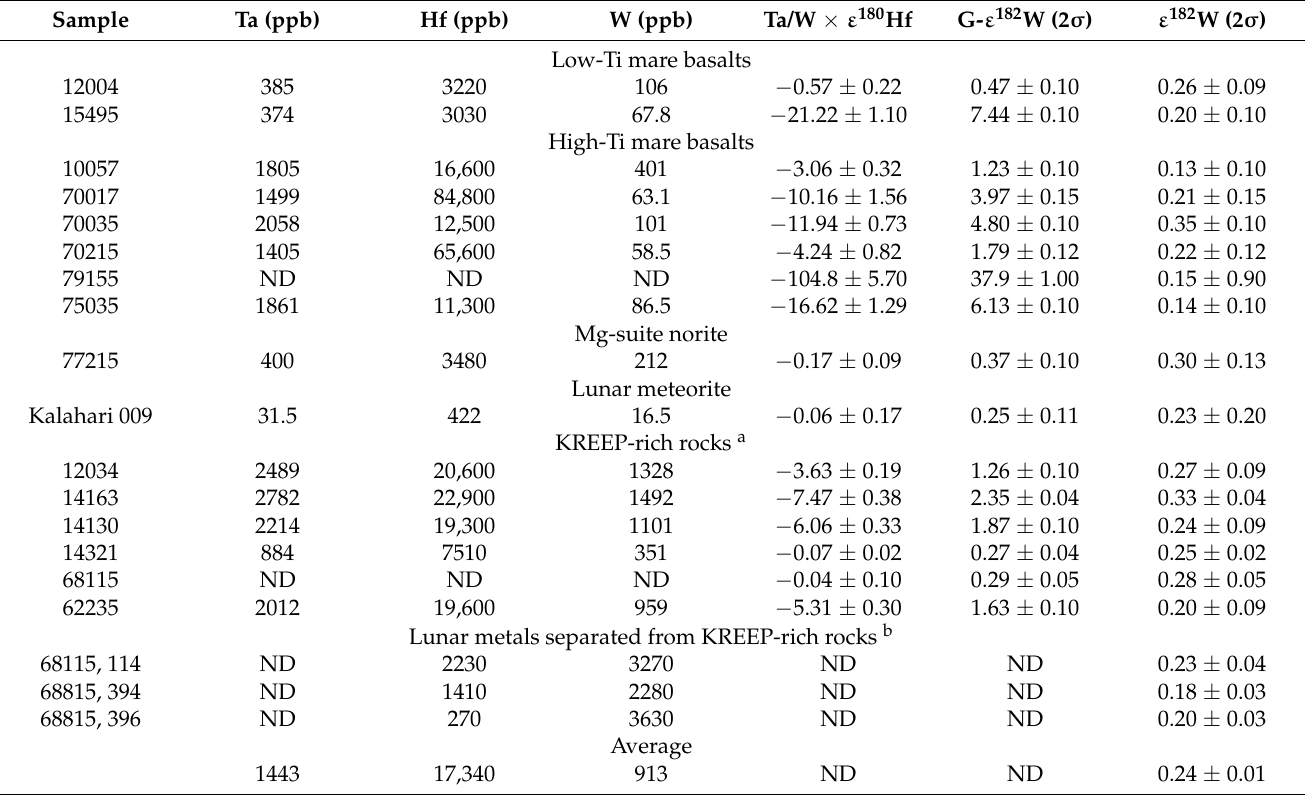
Table 2. Ta, Hf, W abundances and ε 182 W values of lunar rocks (modified after